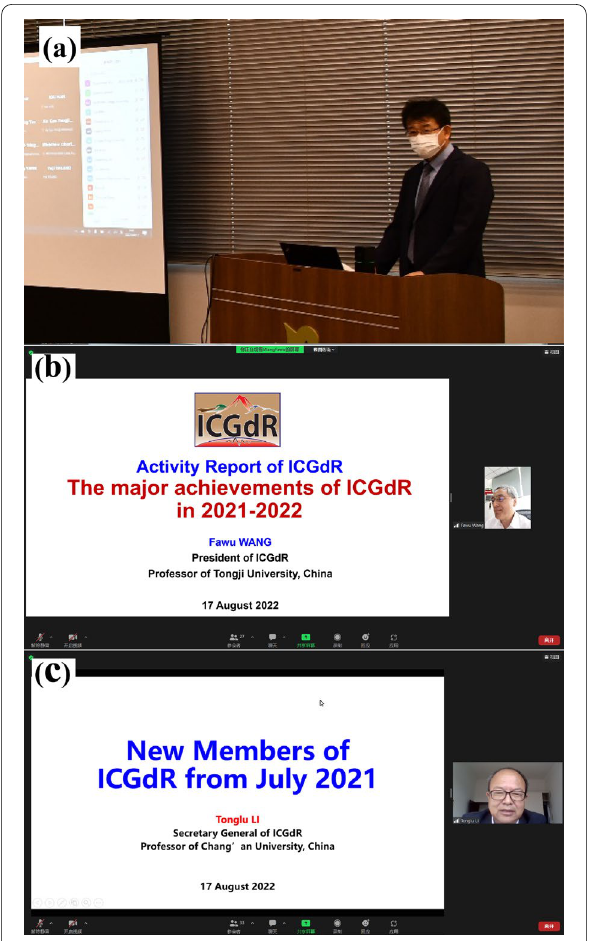
Fig. 2 Opening ceremony: a Opening speech by Prof. Masaho Yoshida gave an opening speech; b Activity Report of ICGdR by